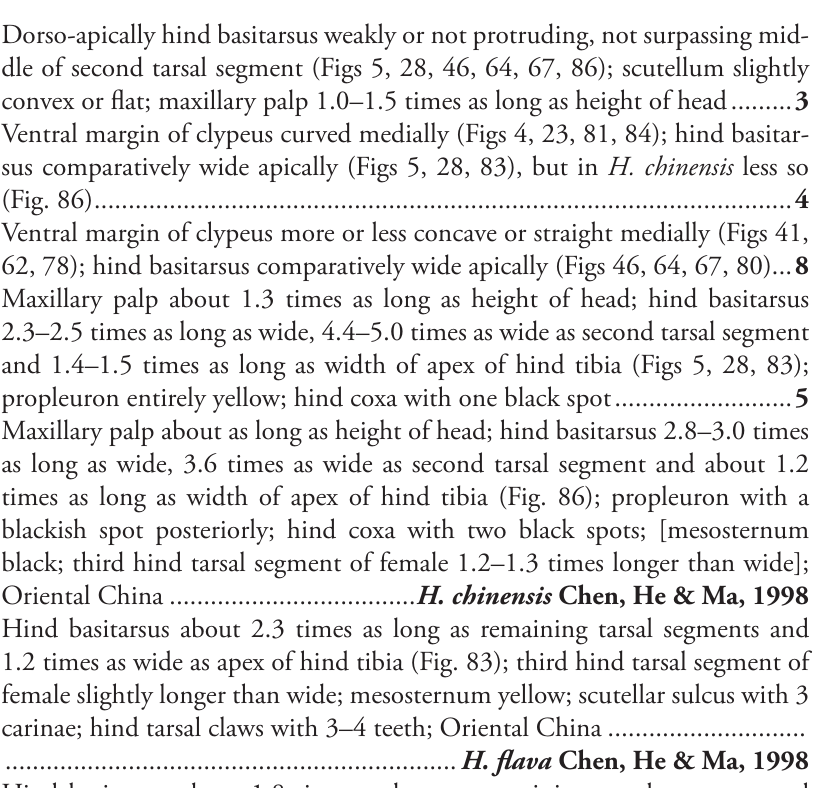
– Dorso-apically hind basitarsus weakly or not protruding, not surpassing mid- dle of second tarsal segment (Figs 5, 28, 46, 64, 67, 86); scutellum slightly convex or flat; maxillary palp 1.0–1.5 times as long as height of head ......... 3 3 Ventral margin of clypeus curved medially (Figs 4, 23, 81, 84); hind basitar- sus comparatively wide apically (Figs 5, 28, 83), but in H. chinensis less so (Fig. 86) ...................................................................................................... 4 – Ventral margin of clypeus more or less concave or straight medially (Figs 41, 62, 78); hind basitarsus comparatively wide apically (Figs 46, 64, 67, 80)... 8 4 Maxillary palp about 1.3 times as long as height of head; hind basitarsus 2.3–2.5 times as long as wide, 4.4–5.0 times as wide as second tarsal segment and 1.4–1.5 times as long as width of apex of hind tibia (Figs 5, 28, 83); propleuron entirely yellow; hind coxa with one black spot .......................... 5 – Maxillary palp about as long as height of head; hind basitarsus 2.8–3.0 times as long as wide, 3.6 times as wide as second tarsal segment and about 1.2 times as long as width of apex of hind tibia (Fig. 86); propleuron with a blackish spot posteriorly; hind coxa with two black spots; [mesosternum black; third hind tarsal segment of female 1.2–1.3 times longer than wide]; Oriental China .................................... H. chinensis Chen, He & Ma, 1998 5 Hind basitarsus about 2.3 times as long as remaining tarsal segments and 1.2 times as wide as apex of hind tibia (Fig. 83); third hind tarsal segment of female slightly longer than wide; mesosternum yellow; scutellar sulcus with 3 carinae; hind tarsal claws with 3–4 teeth; Oriental China ............................. .................................................................. H. flava Chen, He & Ma, 1998 – Hind basitarsus about 1.8 times as long as remaining tarsal segments and 1.3–1.4 times as wide as apex of hind tibia (Figs 5, 28); third hind tarsal segment of female about twice as long as wide; mesosternum black; scutellar sulcus with 5–6 carinae; hind tarsal claws with 5–8 teeth ............................ 6 7 Hind tarsal claws with 8 large teeth (Fig. 8); face finely punctate; hind ba- sitarsus largely blackish (Fig. 5); temples parallel-sided (Fig. 7) and slightly punctate; Philippines, Japan .............................. H. muirii ( Fullaway, 1919) – Hind tarsal claws with 5 large teeth (Fig. 27); face rugose-punctate; hind basitarsus only apically blackish (Fig. 28); temples rather bulging (Fig. 23), roughly punctate dorsally and rugose-punctate ventrally; Vietnam ................ ............................................................................ H . khuatbaolinhae sp. n. 8 Second-fourth hind tarsal segments slender, distinctly longer than wide (Fig. 64); dorsal side of hind basitarsus distinctly more curved than nearly straight ventral side and with a rather distinct apical prominence (Fig. 64); hind femur yellow; [posterior half of notauli widely crenulate; frons entirely smooth]; Oriental China, Nepal ... H. townesi Dangerfield & Austin, 1990 – Second-fourth hind tarsal segments robust, slightly longer than wide (Figs 46, 67, 80); dorsal side of hind basitarsus similar to ventral side and truncate api- cally, without apical prominence (Figs 46, 67, 80); hind femur largely dark brown or black dorsally ...............................................................................